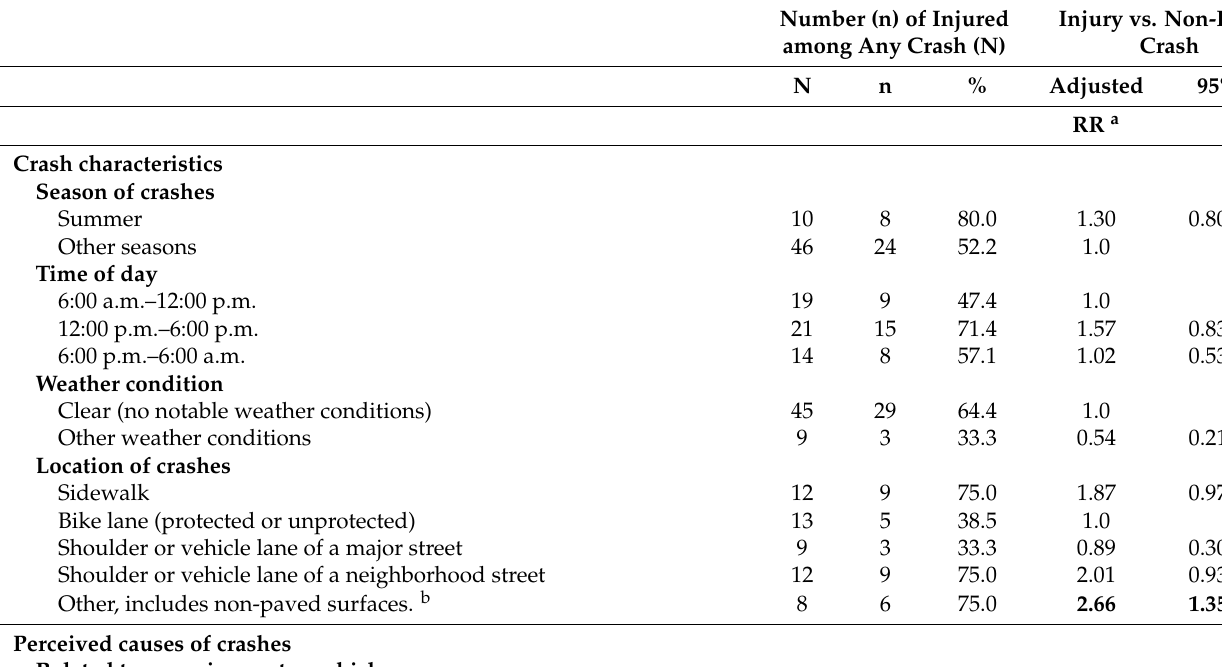
Number (n) of Injured Injury vs. among Any Crash (N)